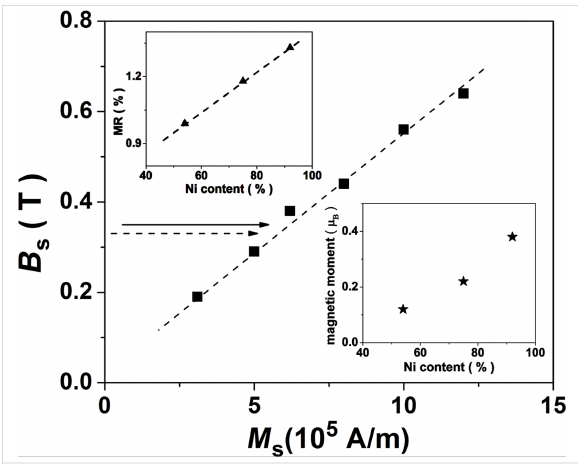
Figure 7: Saturation field strength as a function of the spontaneous magnetization obtained by micromagnetic simulations of a single nano- wire. The average magnetic moment of a Ni atom as a function of the Ni content as obtained from magnetization measurements on nano- wire arrays is presented in the lower inset. The magnetoresistive effect as a function of the Ni content as obtained from single nanowire mea- surements is shown in the upper